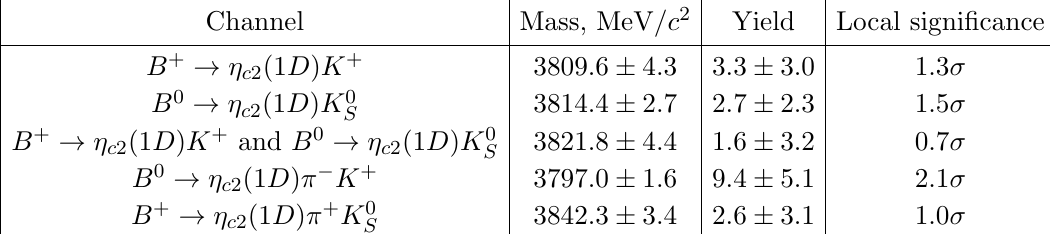
(right). (cid:17) c 2 (1 D ) (cid:25) + K 0 S !